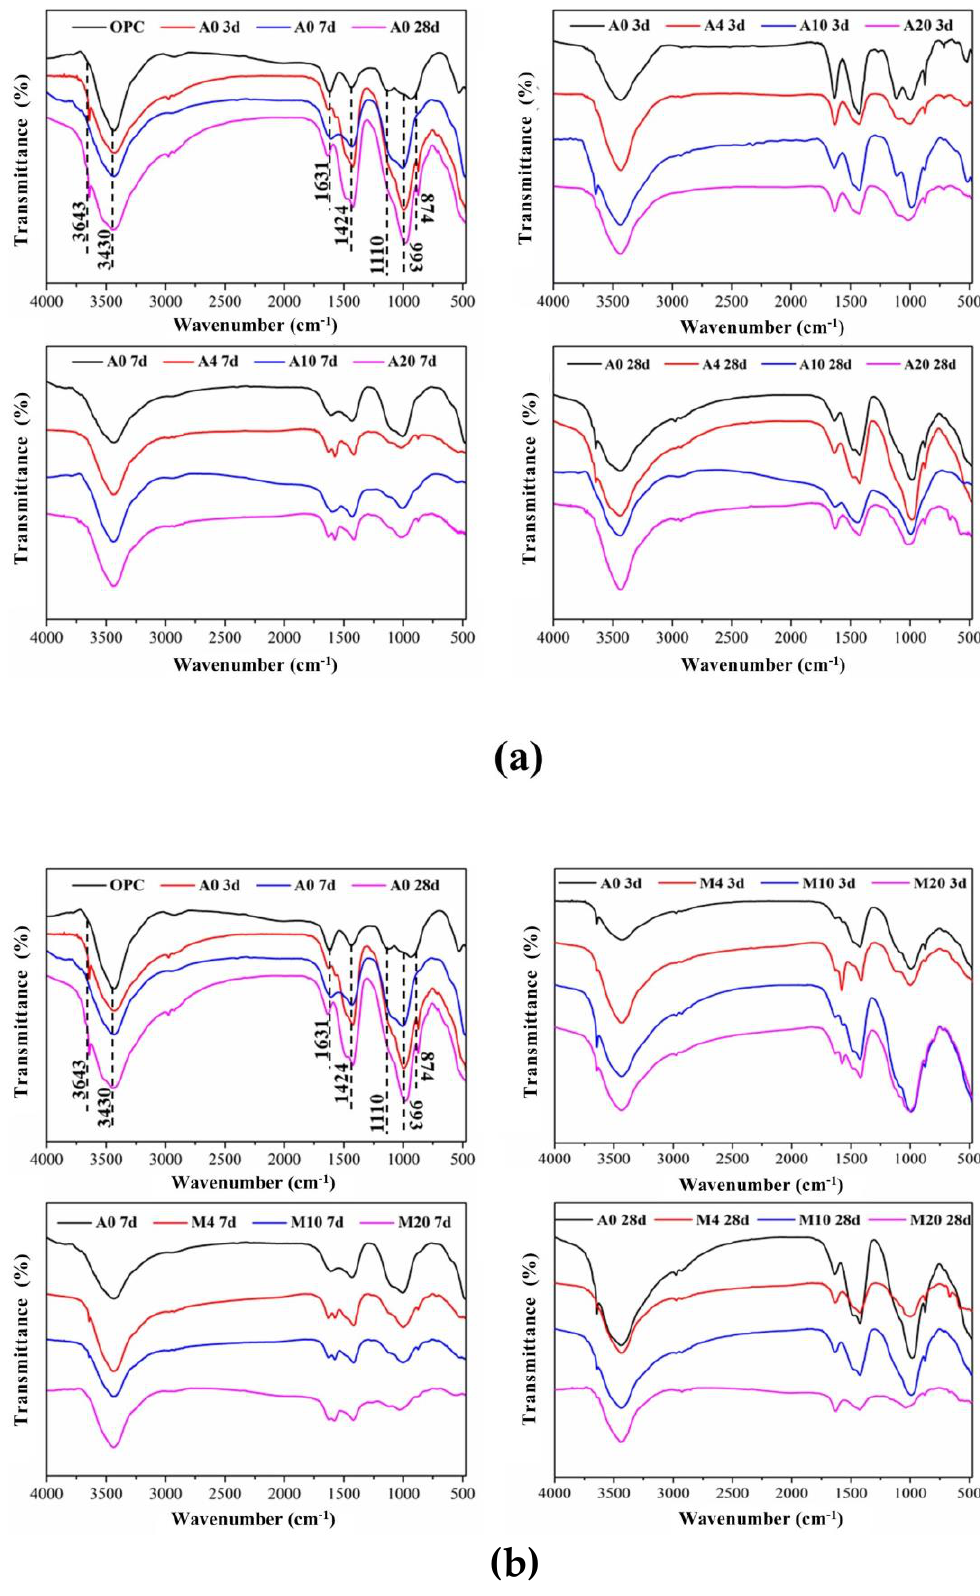
Figure 12. Infrared spectra of samples of different proportions at different ages: ( a ) attapulgite; ( b ) montmorillonite.